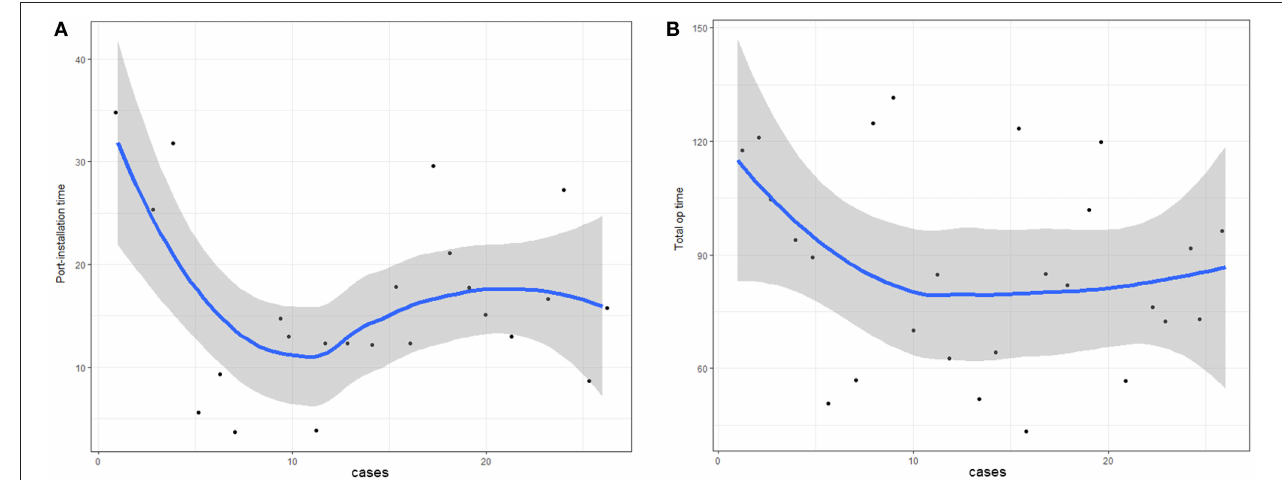
FIGURE 2 | Learning curve of (A) port-installation time and (B) total operation